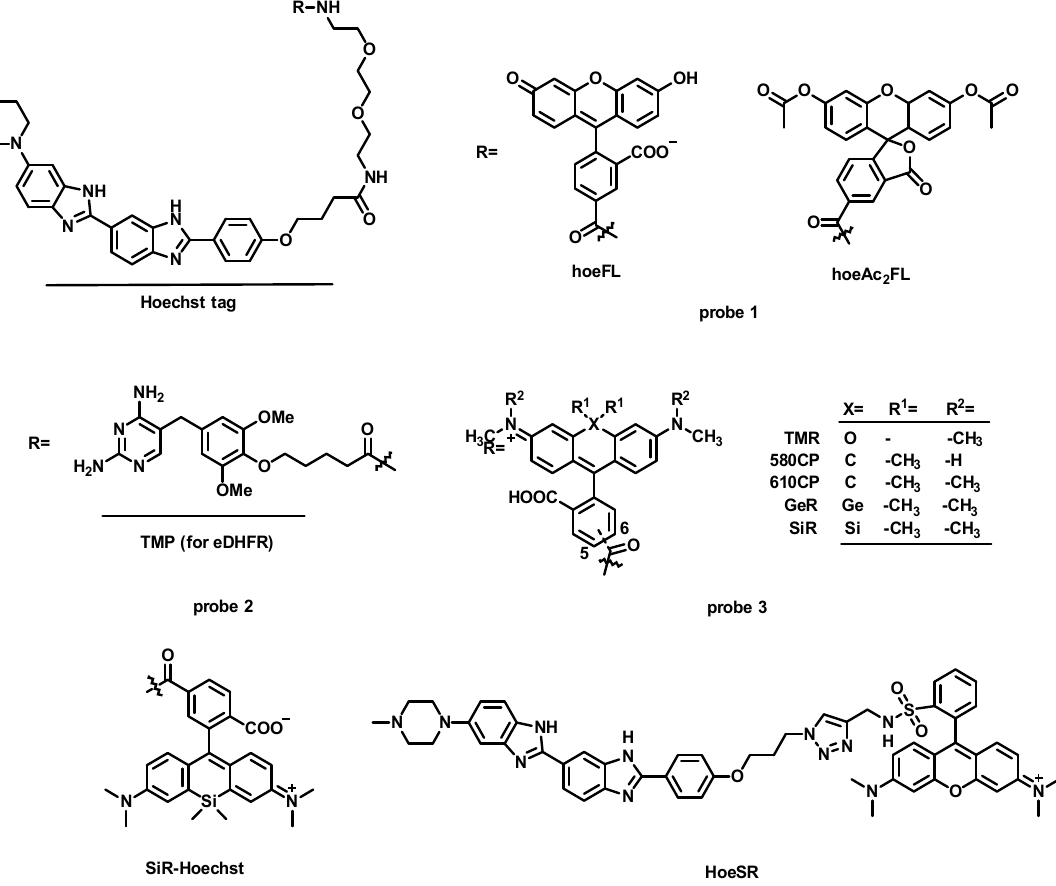
Figure 5. Structures of probe 1, probe 2, probe 3, SiR-Hoechst and HoeSR.